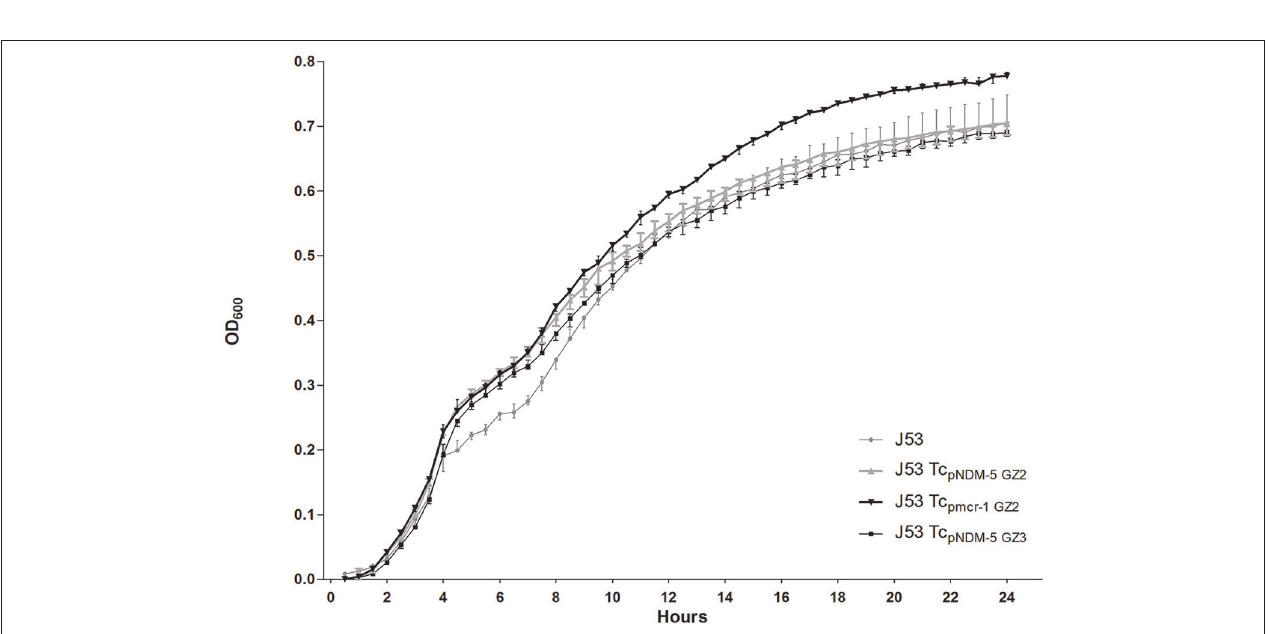
FIGURE 2 | Growth kinetics of E. coli J53 and its transconjugants (Tc pNDM - 5GZ2 , Tc pmcr - 1GZ2 and Tc pNDM - 5GZ3 ). Values represent the mean ± standard variations obtained from three independent experiments.